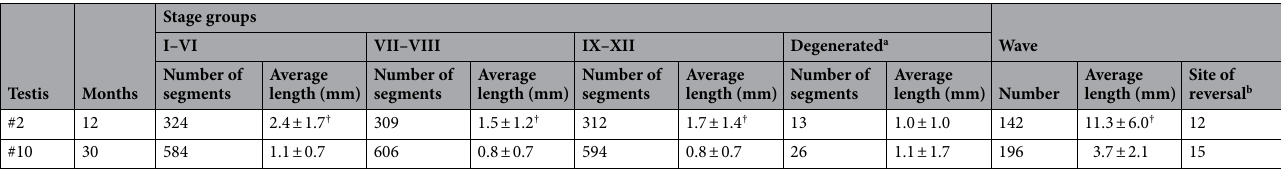
Table 2. Summary of stages and waves in seminiferous tubules. a The portion with the absence of spermatogenesis. b The site at which the direction of waves is reversed. † Mean ± S.D., significantly different between #2 and #10 (P <